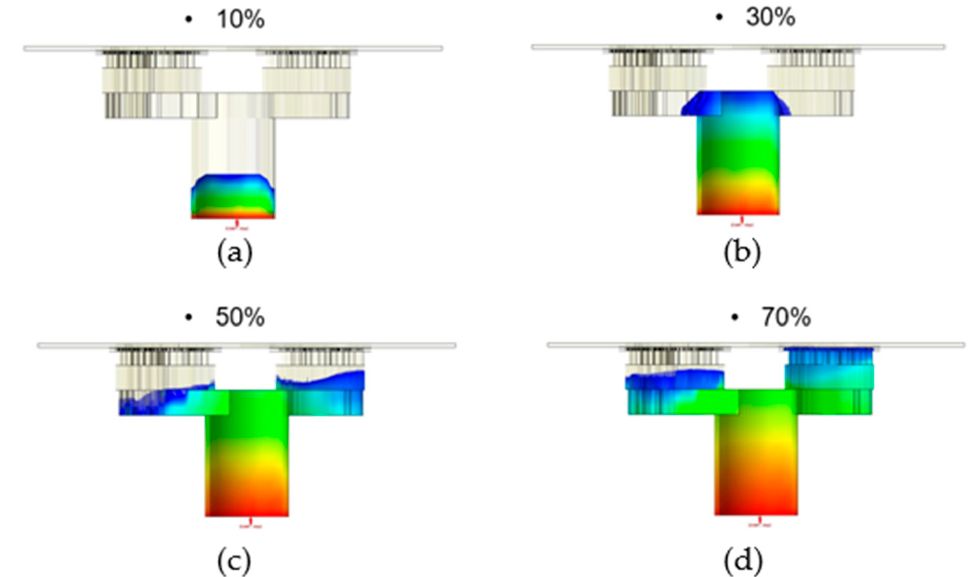
Figure 11. The flow front of the runner with a flow rate of 0.03 cm 3 /sec in Case 1. ( a ) Filling 10%; ( b ) filling 30%; ( c ) filling 50%; and ( d ) filling 70%.